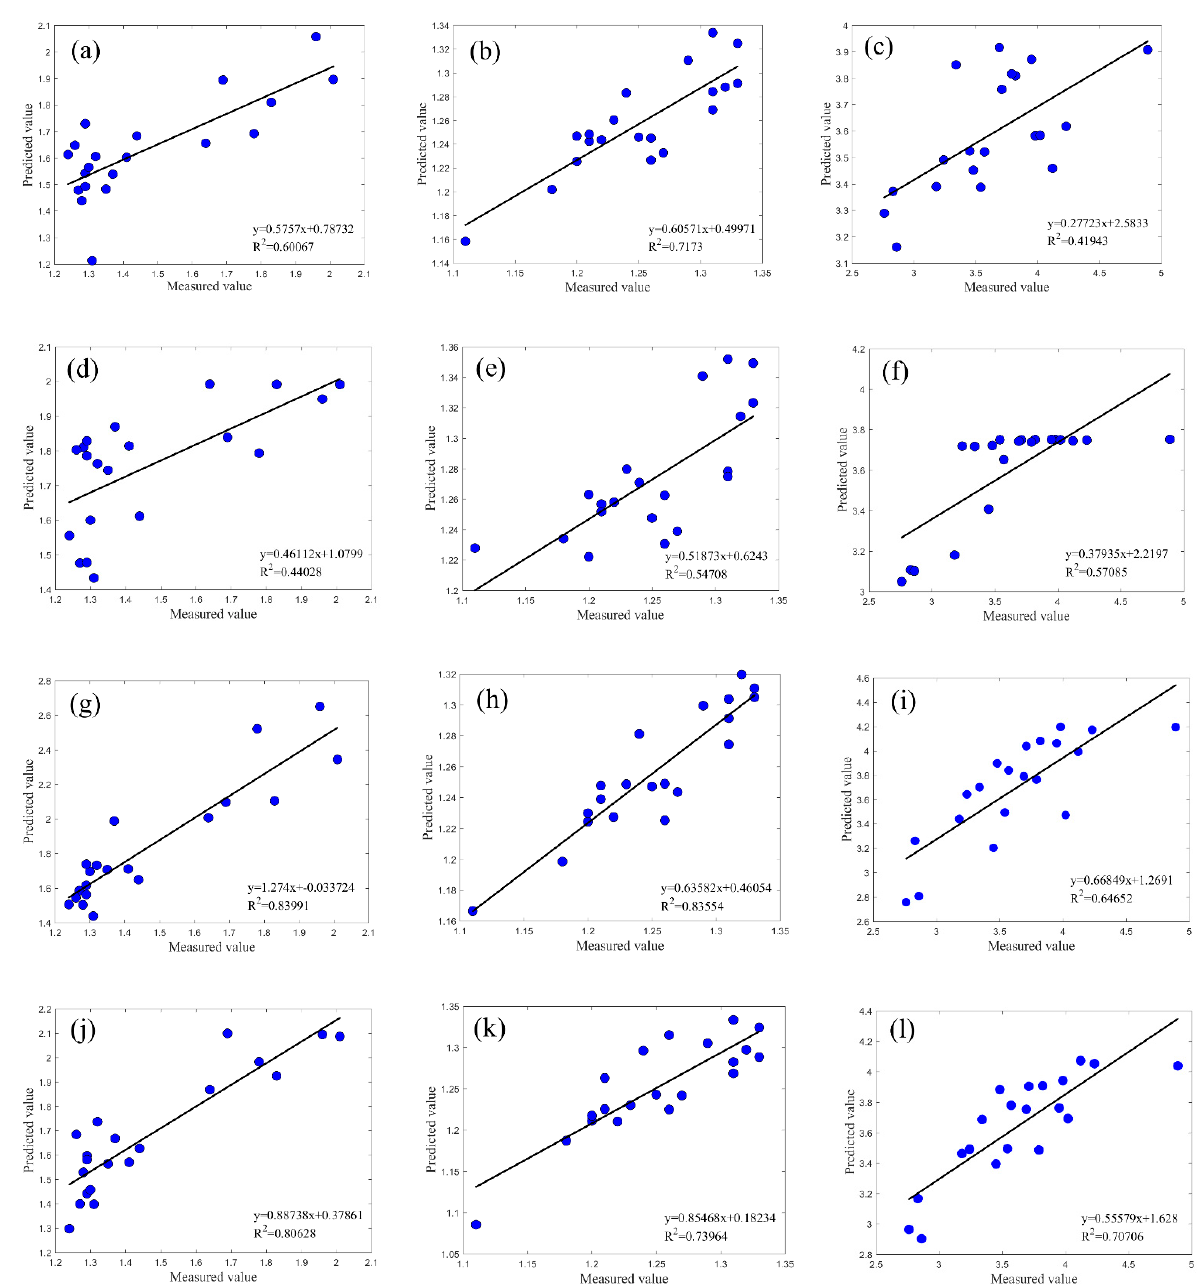
Figure 4. Scatter diagram of the measured and predicted data. Note: ( a ) Alfalfa-covered land SVR model; ( b ) Wheat-covered land SVR model; ( c ) Bare land SVR model; ( d ) Alfalfa-covered land RF model; ( e ) Wheat-covered land RF model; ( f ) Bare land RF model; ( g ) Alfalfa-covered land BPNN model; ( h ) Wheat-covered land BPNN model; ( i ) Bare land BPNN model; ( j ) Alfalfa-covered land; ( k ) Wheat-covered land ELM model; ( l ) Bare area ELM model.